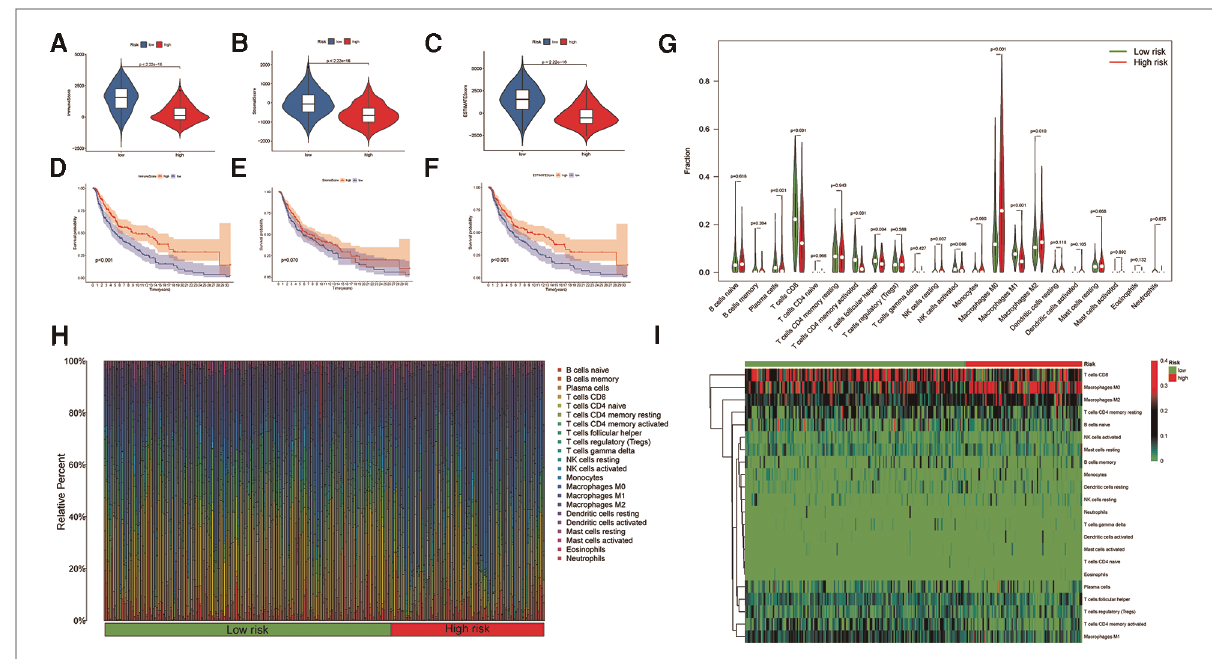
FIGURE 5 Association between the signature and immune landscape in melanoma. ( A – C ) The difference in immune, stromal, and ESTIMATE scores between the high- and low-risk groups. ( D – F ) Kaplan-Meier survival analyses of the risk scores based on the immune, stromal, and ESTIMATE scores, respectively. ( G ) Comparison of the in fi ltrating immune cells between the low- and high-risk groups. ( H ) Barplot showing the proportions of in fi ltrating immune cells in the low- and high-risk groups. ( I ) Heatmap for differences in the scores of immune cells between low- and high-risk